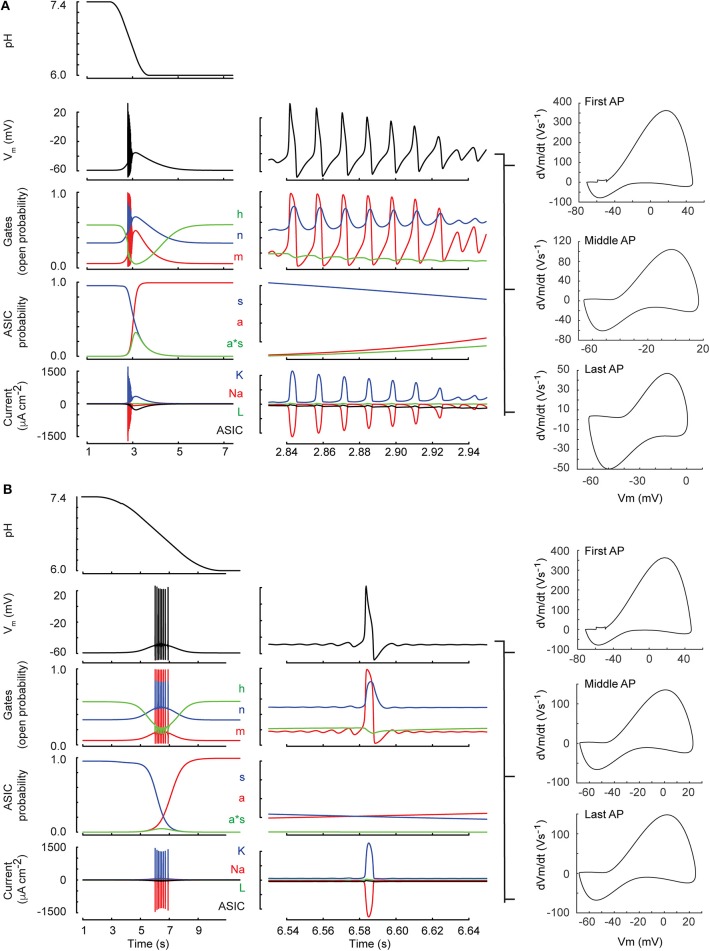
Neuronal model behavior (classical Hodgkin-Huxley model). Shown are two simulations of the neuronal response to a pH drop to pH 6.0 of 1 (A) resp. 6 s duration (B). The center column shows a zoom of 120 ms duration selected toward the middle of the firing. From top to bottom, the figures present the time course of the pH, the membrane potential (Vm), the open probabilities of the gates m, h, and n (see Materials and Methods, section Incorporation of IASIC1a into the Hodgkin-Huxley Model of the Nerve Action Potential), the ASIC behavior in terms of activation of the activation (a) and the sensitization gate (s), and of the product a·s, and the current related to the voltage-gated sodium (Na) and potassium (K) channels, the leak current (L), and the ASIC-mediated sodium current (ASIC). For both ramp types, phase-plane plots of the first AP, an AP in the middle and the last AP of the burst are shown in the right column.